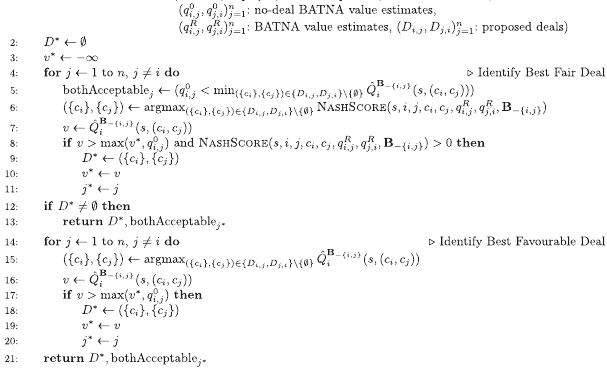
Deviator Agent algorithms